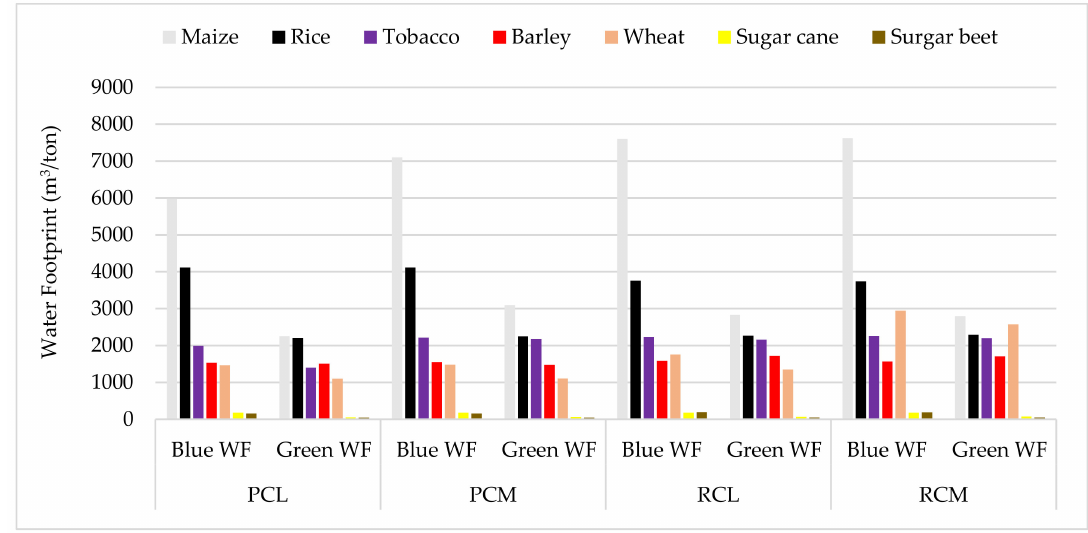
Figure 3. Annual blue and green water footprints of major crops in sub-regions of Peshawar Basin (1986–2015).